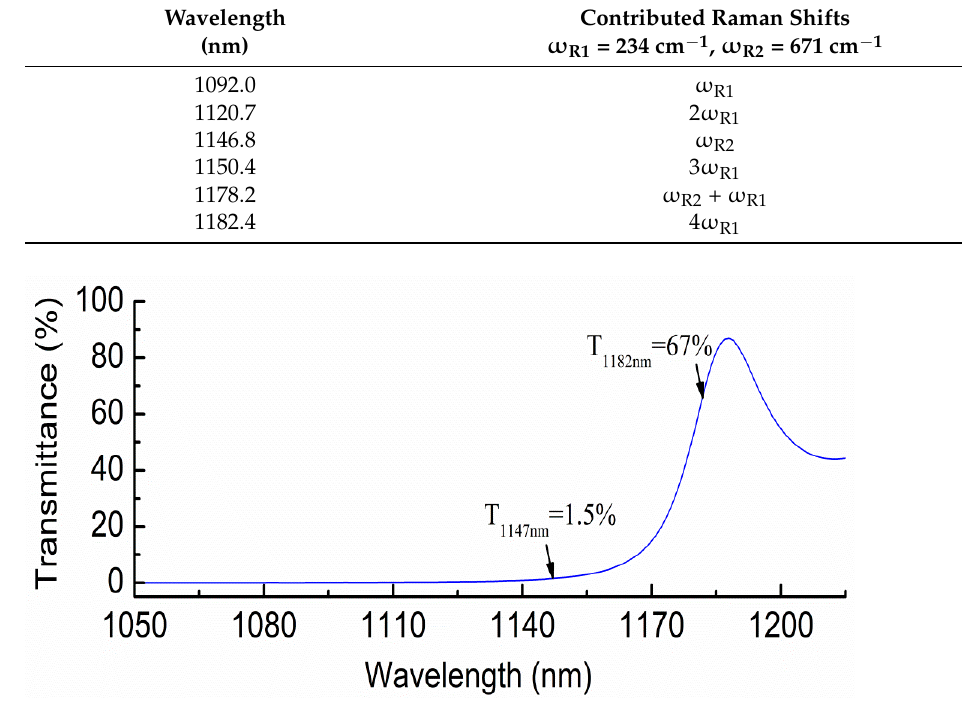
Figure 2. Transmittance curve of the OC mirror for different wavelengths.